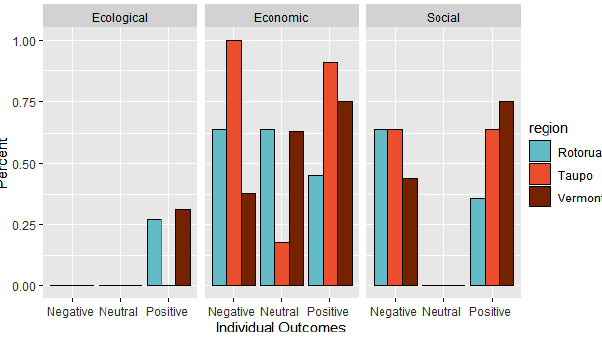
Fig. 5 . Percentage individual outcomes by